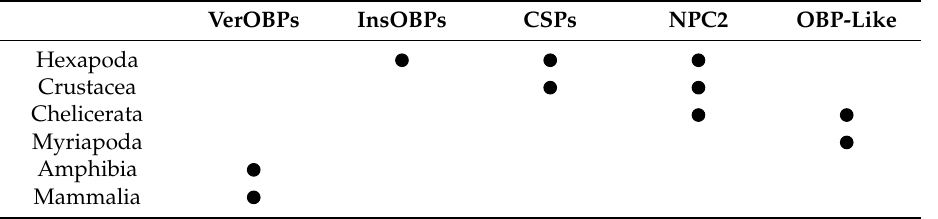
Table 1. Soluble proteins used for chemical communication across evolution. The small number of CSPs in Crustacea (1–3) probably does not support a role in chemical communication. NPC2 proteins occur in all phyla, but only in invertebrates their number and diversity indicate a function in chemical communication.